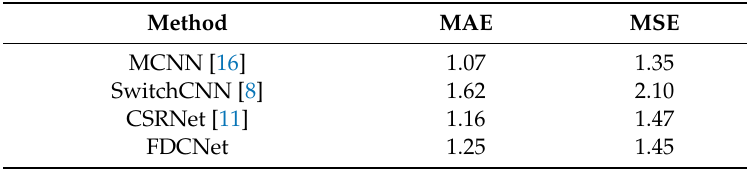
Table 4. The estimation errors on UCSD dataset.